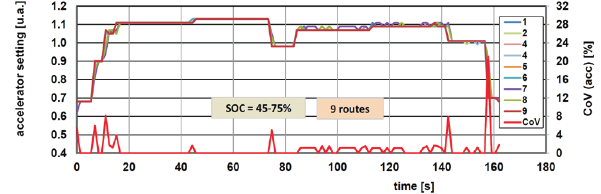
Fig. 4. Analysis of the input signal